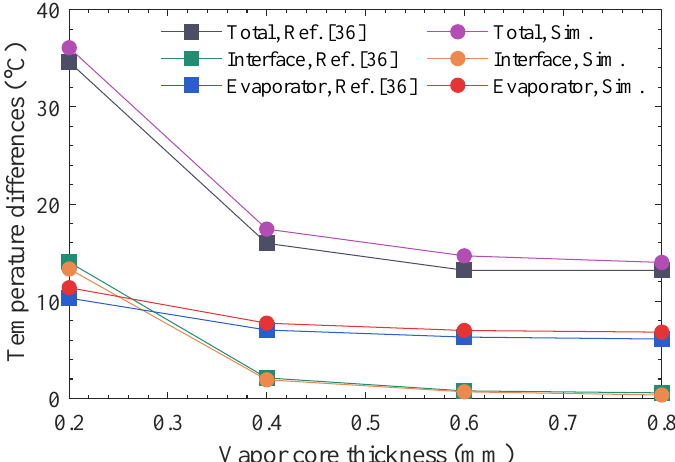
Figure 5. Comparison with numerical results of the ultra-thin heat pipe